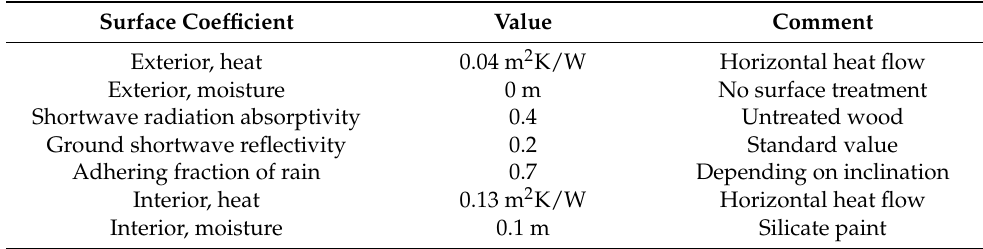
Table 4. Surface transfer